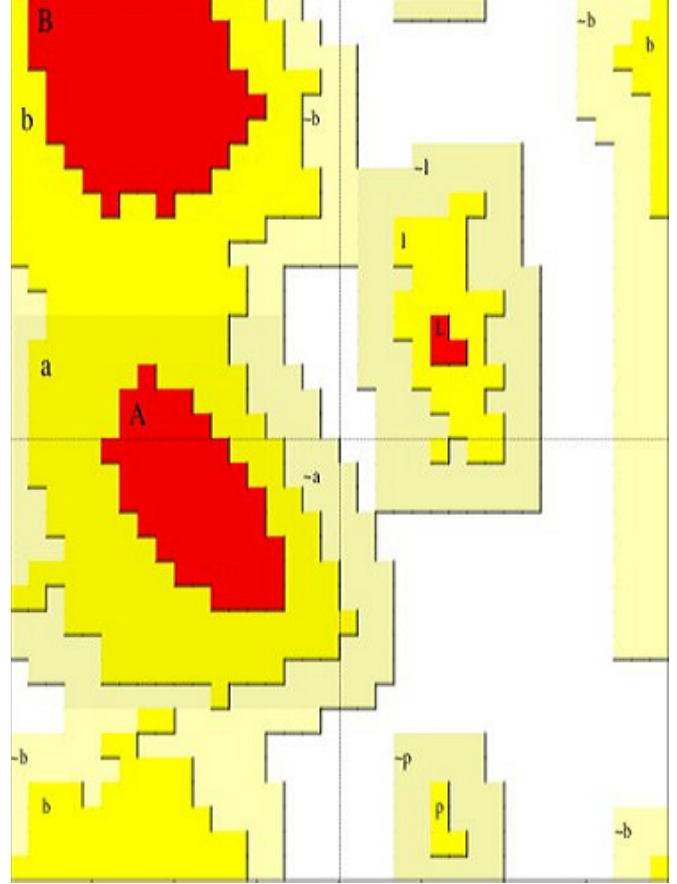
Figure 9. The Ramachandran Plot Region. The red area represents the core area. The yellow region is the allowable region in which the conformation can exist and be stable in stereochemistry. The brown region is the maximum allowable region, in which the conformation can exist stereochemically, but it is unstable. The white area represents the disallowed area; the conformation is not allowed to exist.